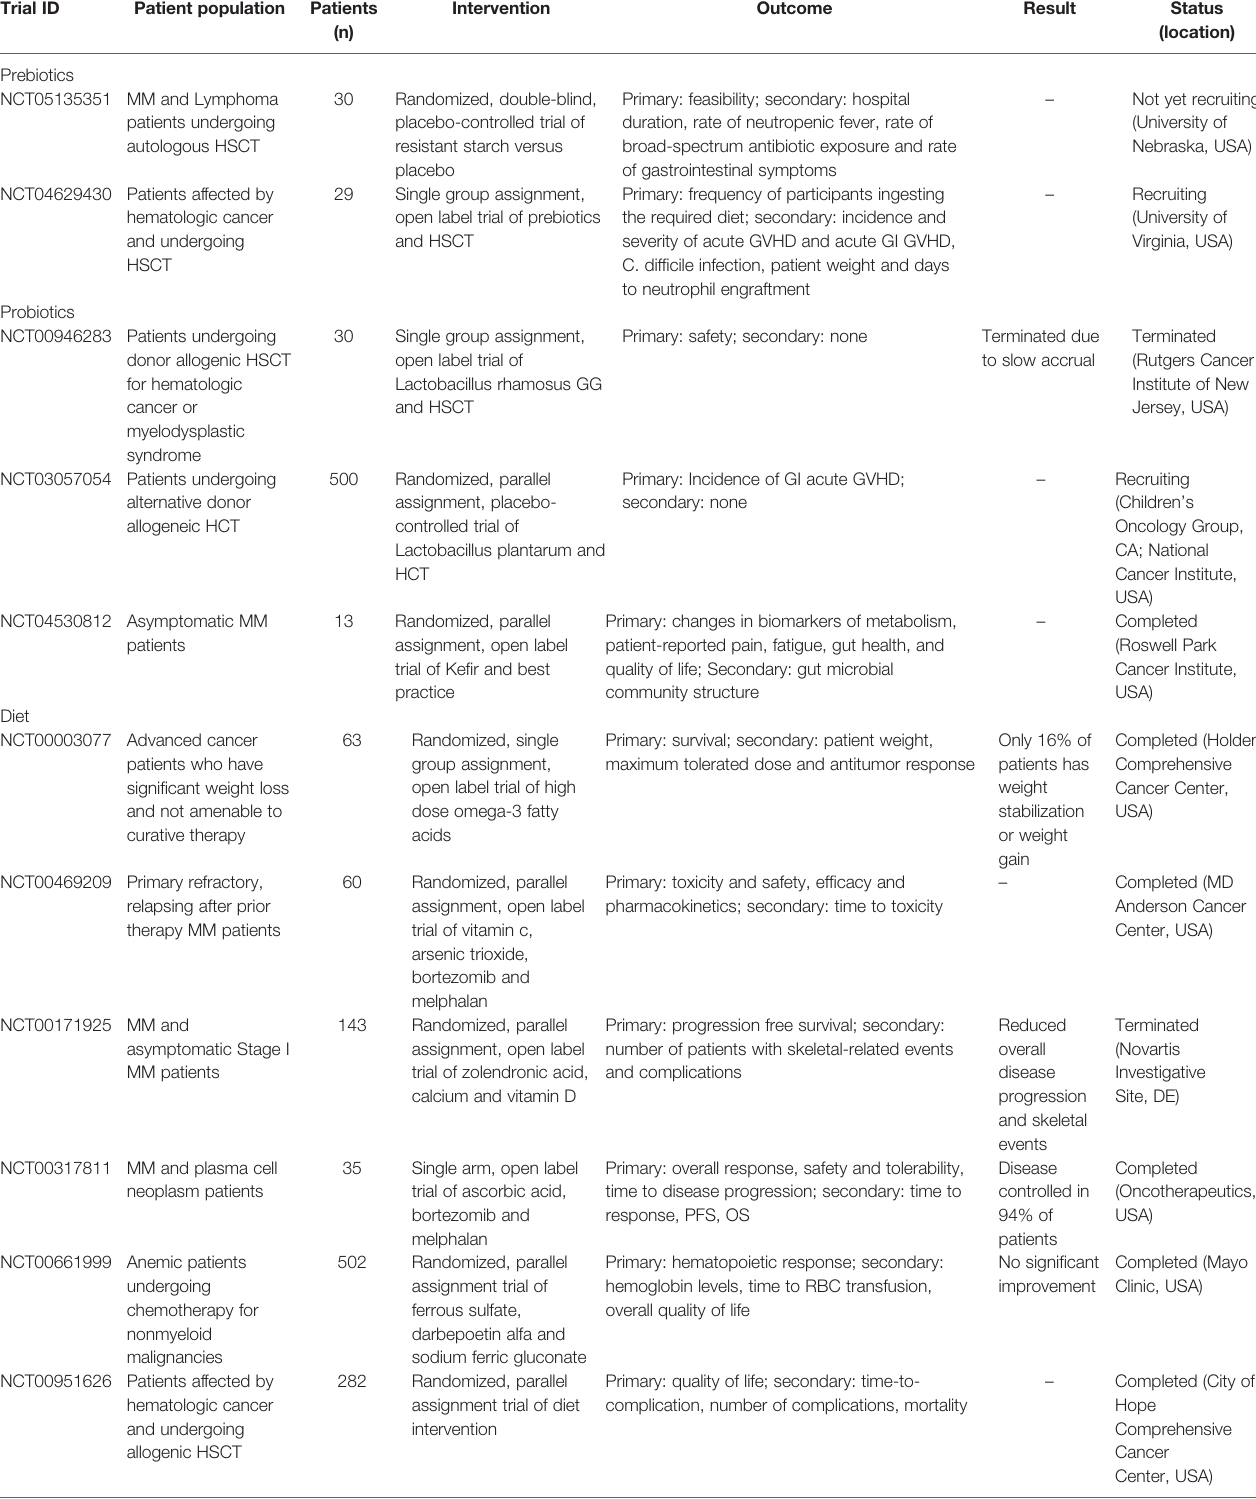
TABLE 1 | Clinical trials in MM patients. Trial